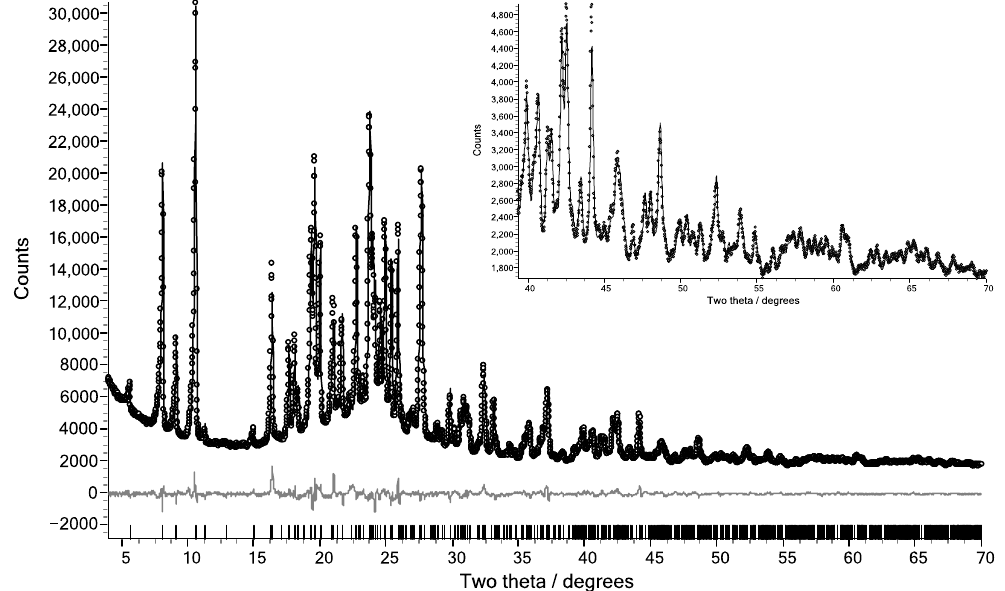
Figure 1. Observed (open circles) and calculated (solid black line) PXRD data for the final Rietveld refined crystal structure of FUR:URE. The difference plot is shown in grey, reflection positions are indicated by vertical markers on the x-axis, and the inset shows the fit to the observed data at a high angle.